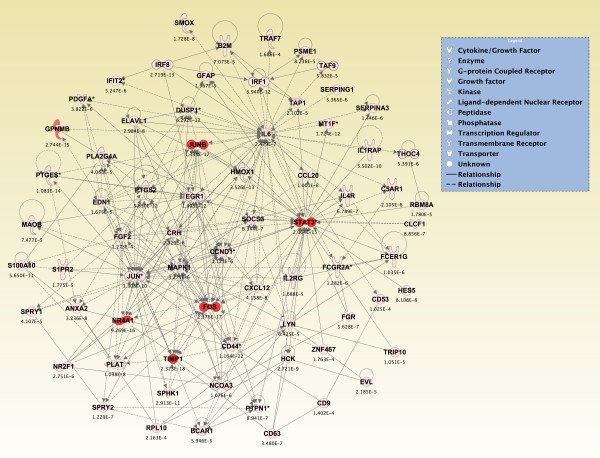
Seizure-induced alteration of cellular movement, inflammatory response, and cell-to-cell signalling/interaction gene network.